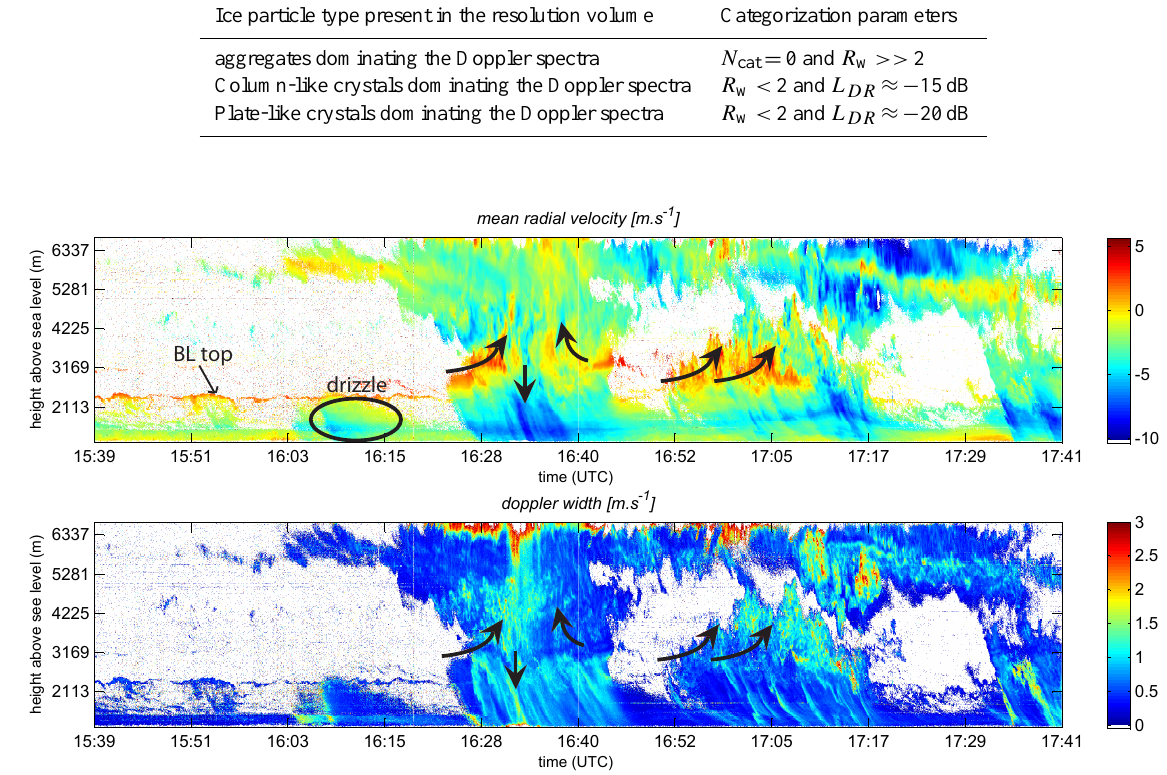
Fig. 10. Radial Mean Doppler velocity (top) and Doppler width (bottom) measured by the TARA radar on 21 July